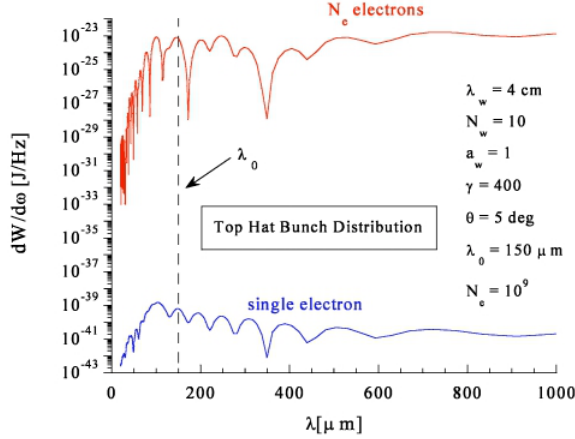
FIG. 9. (Color) Energy spectra for different bunch lengths of a top-hat-shaped electron beam.